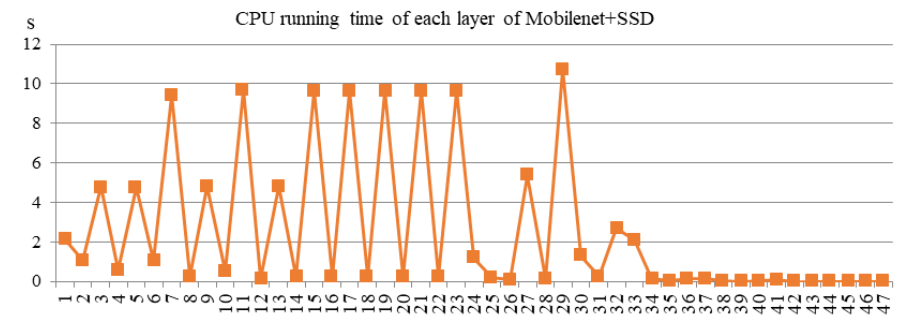
Electronics 2019 , 8 , x FOR PEER REVIEW Figure 13. CPU running time results. Figure 13. CPU running time results. Figure 13. CPU running time results.